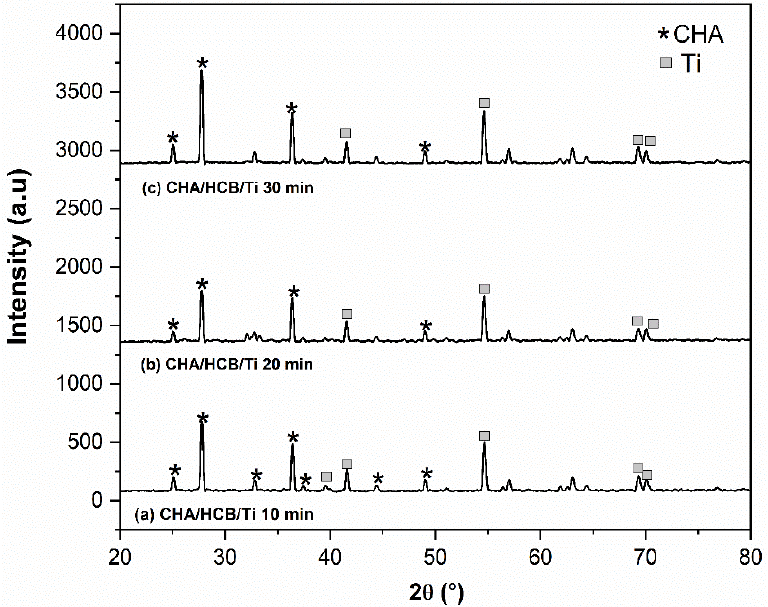
Figure 8. XRD pattern of CHA/HCB/Ti with immersion times variation (min).